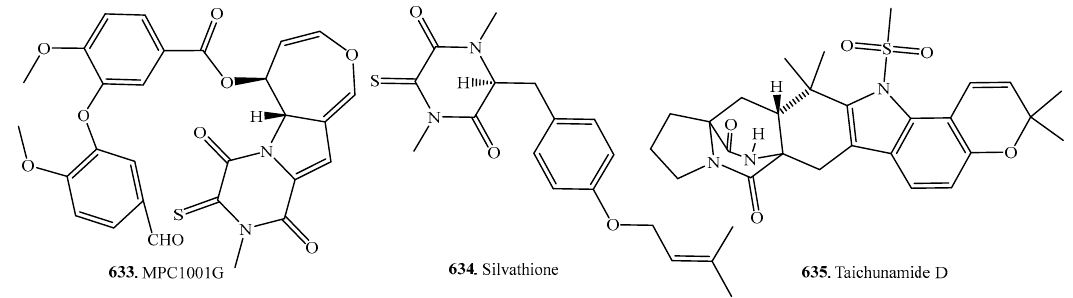
Figure 9. Structures of the other sulfur-containing cyclodipeptide analogs isolated from fungi.